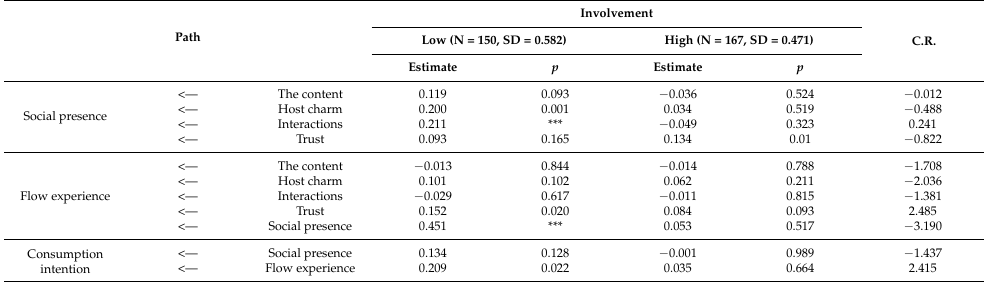
Table 5. Results of the regulation